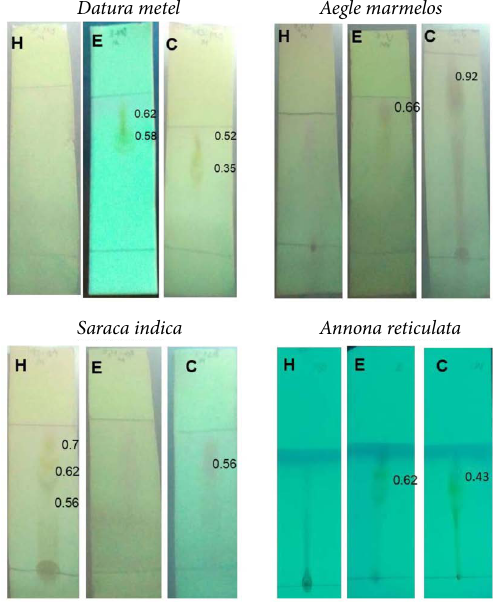
Fig. 1. Iodine exposed Thin layer chromatography of medicinal plants chosen for this study. H – aqueous extract, E – ethanol extract, C- Chloroform